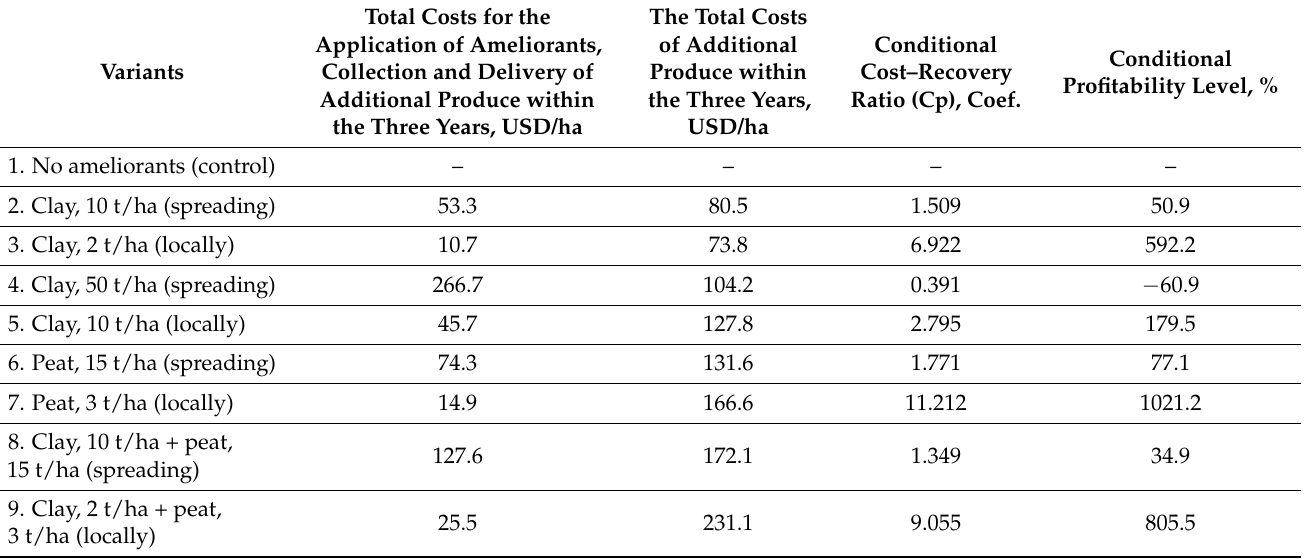
Table 6. Static indicators of economic efficiency of application of structural amelioration (considering the after-effect) on sod-podzolic cohesive sandy